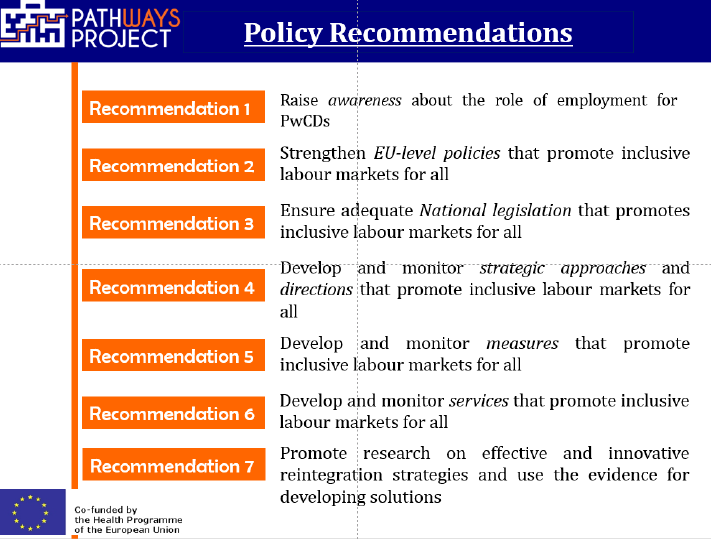
Figure 2. Pathways Policy Recommendations for NCDs and employment.